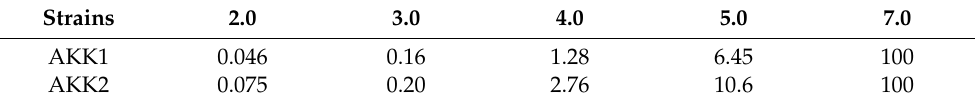
Table 2. Survival rate of strains under different pH values (%).